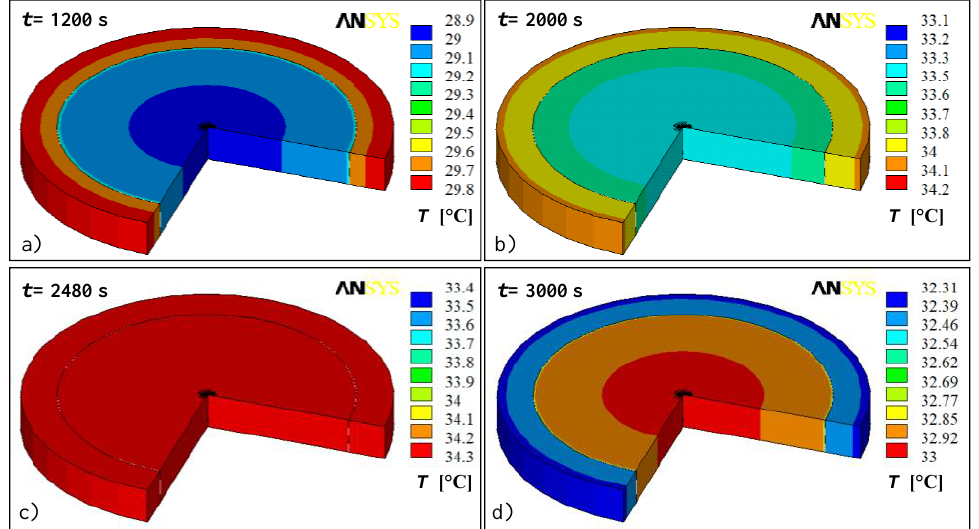
Figure 12. Temperature distribution in probe 2 at chosen times during its heating by 10 °C and subsequent cooling in the climate chamber, a) t = 1200 s, b) t = 2000 s, c) t = 2480 s and d) t = 3000 s.